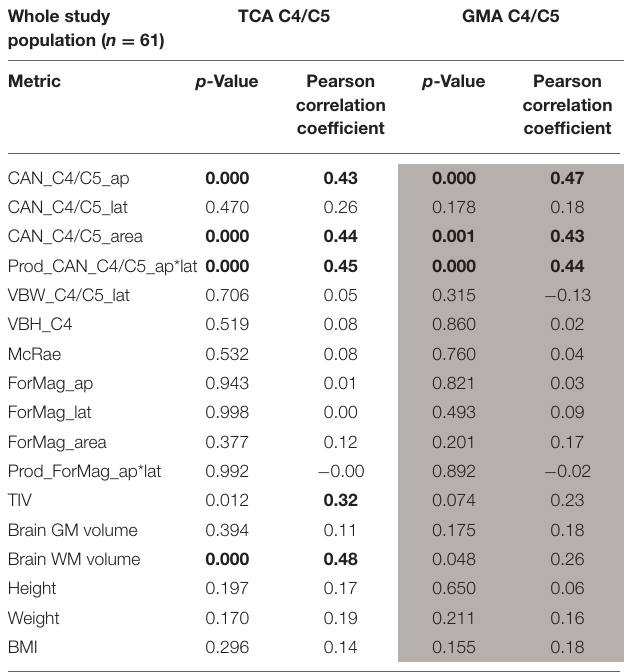
TABLE 2 | Associations between the anatomical metrics and total cross-sectional area (TCA) and gray matter area (GMA) at the C4/C5 level using Pearson correlation